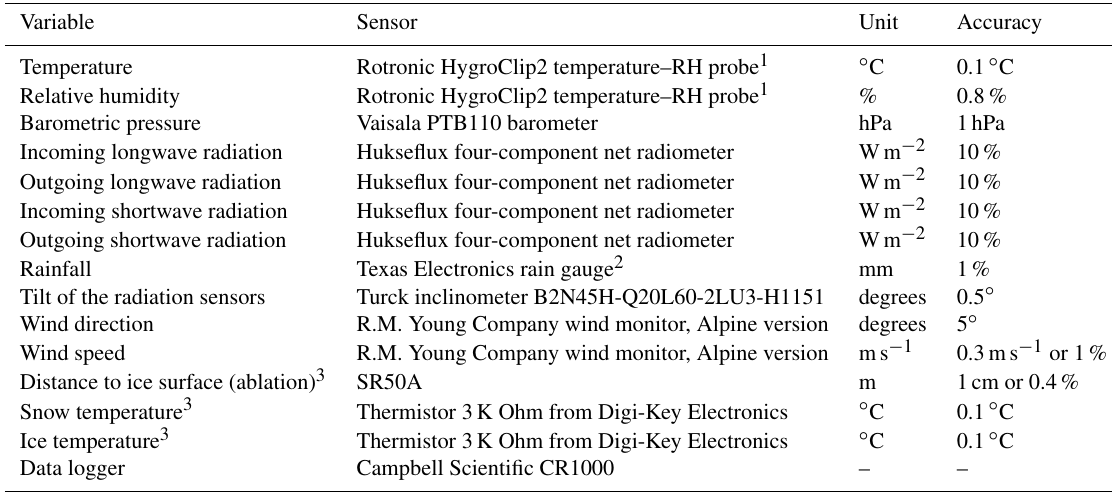
Table 1. Sensors used for the energy balance weather stations (On-Ice and Off-Ice).